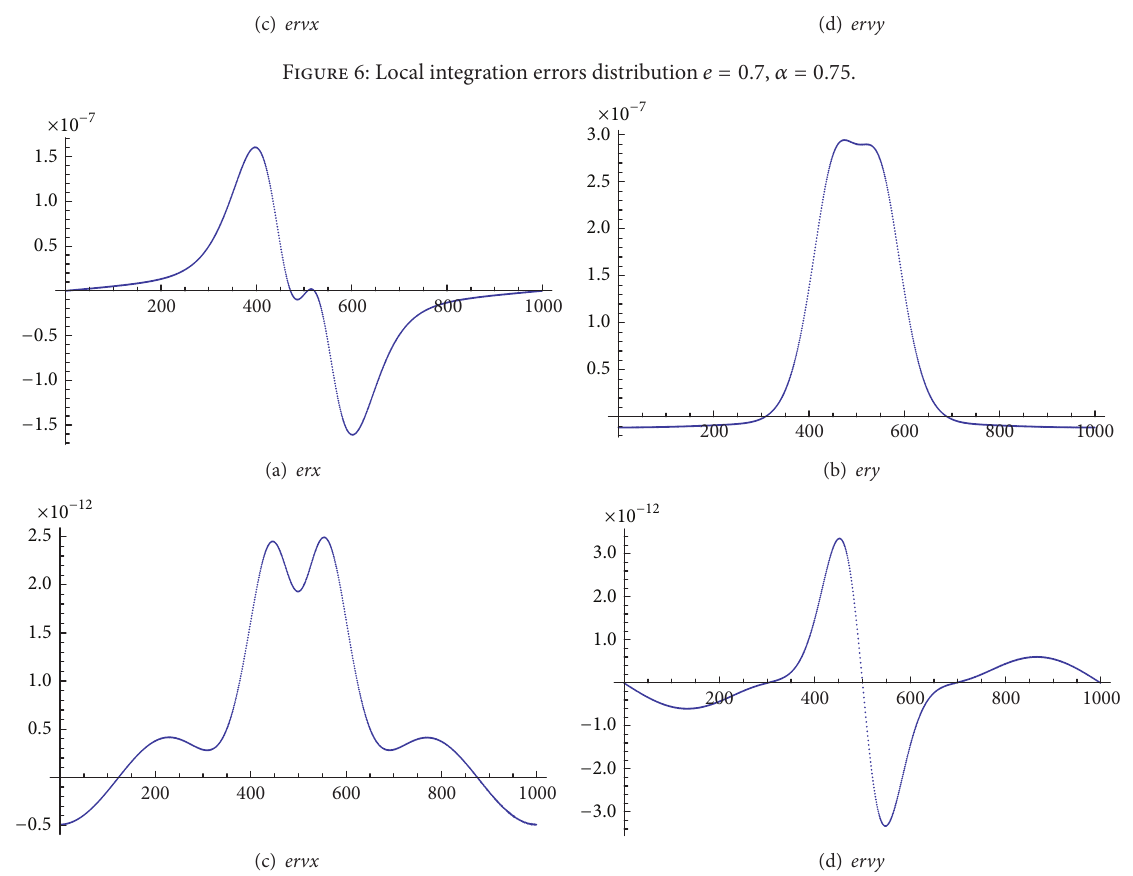
Figure 6: Local integration errors distribution 𝑒 = 0.7 , 𝛼 = 0.75 .